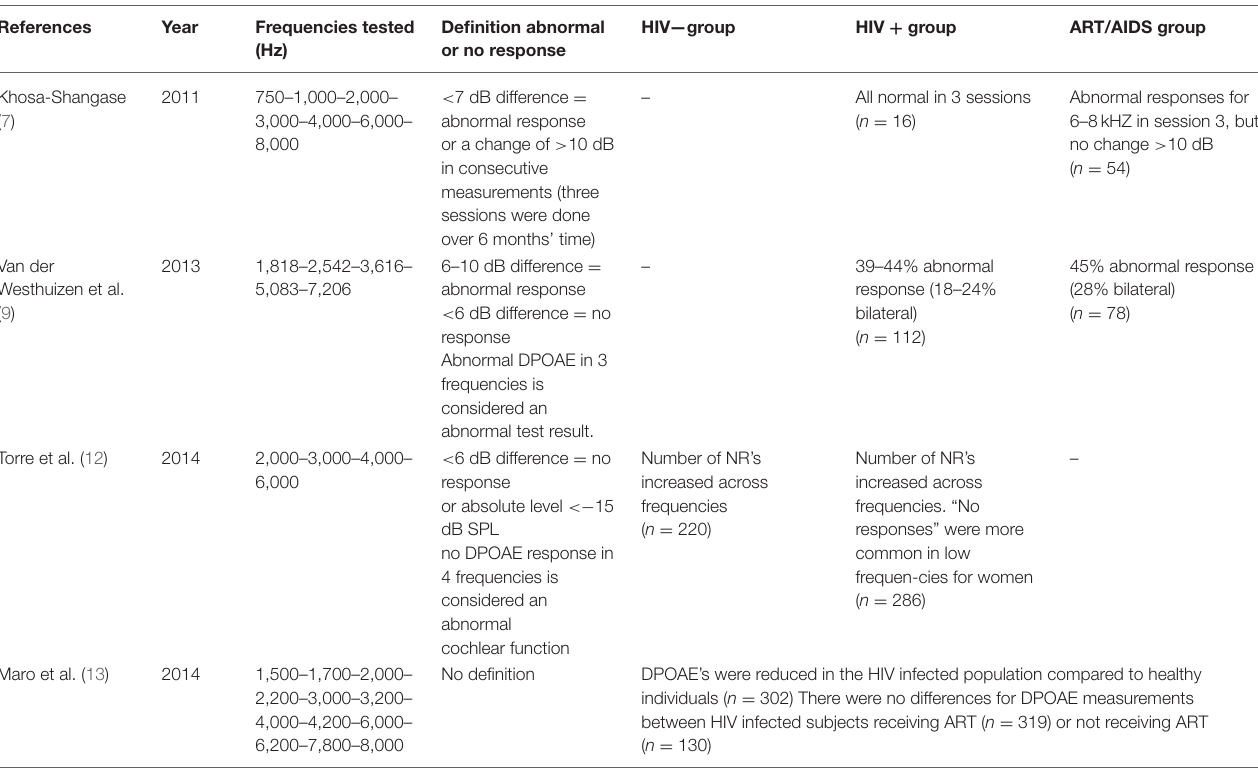
TABLE 1 | Overview of distortion product otoacoustic emission (DPOAE) testing results—prevalence and